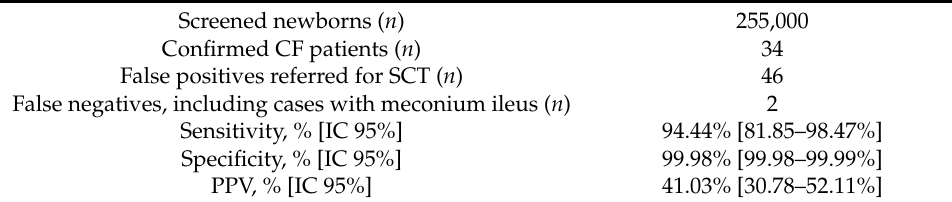
Table 2. Performance indicators for IRT/PAP/IRT